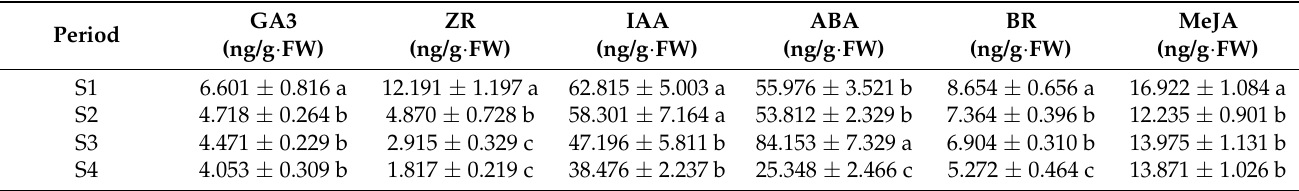
Table 2. Hormone levels during the four periods of stem development in B. juncea var. tumida.